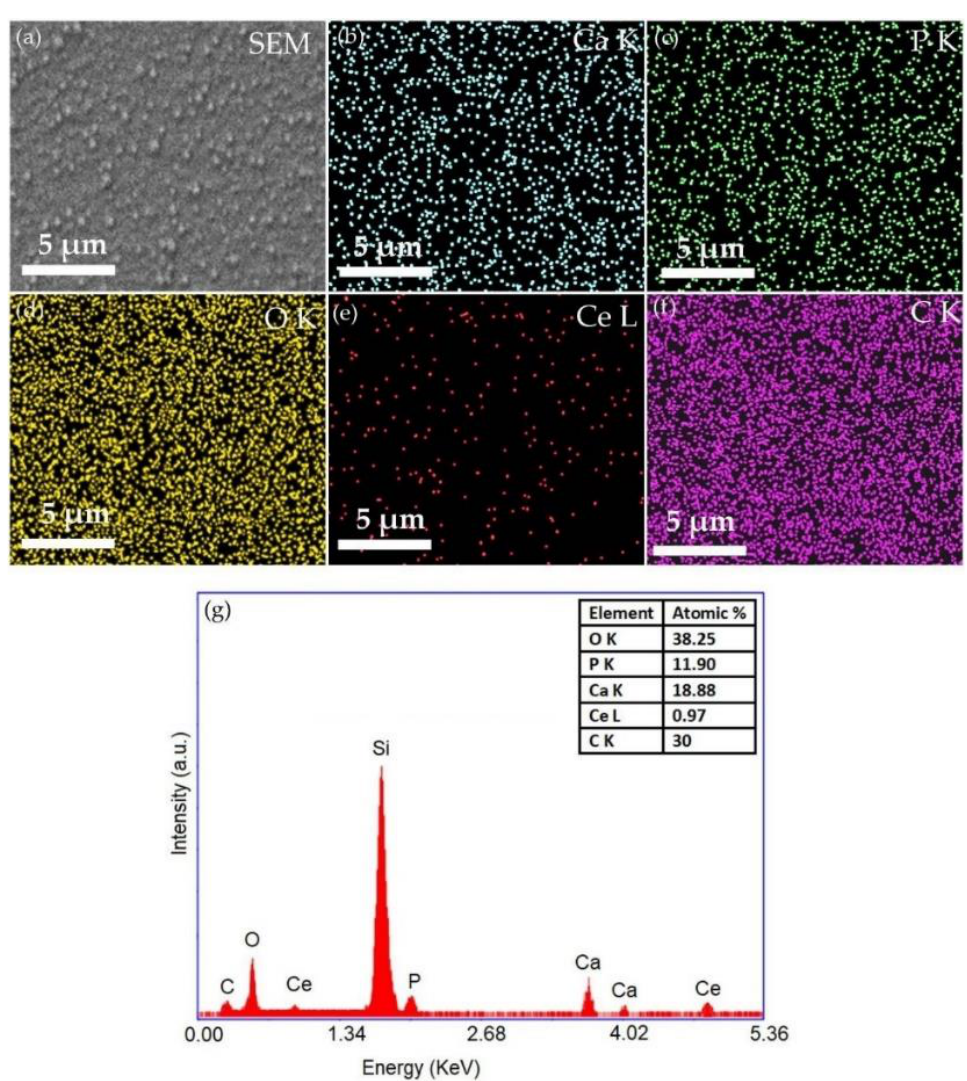
Figure 6. SEM image ( a ), EDS elemental mapping of the constituent elements of 10HApCe-D composite layer coating ( b – f ) and EDS spectrum of 10HApCe-D composite layer ( g ).